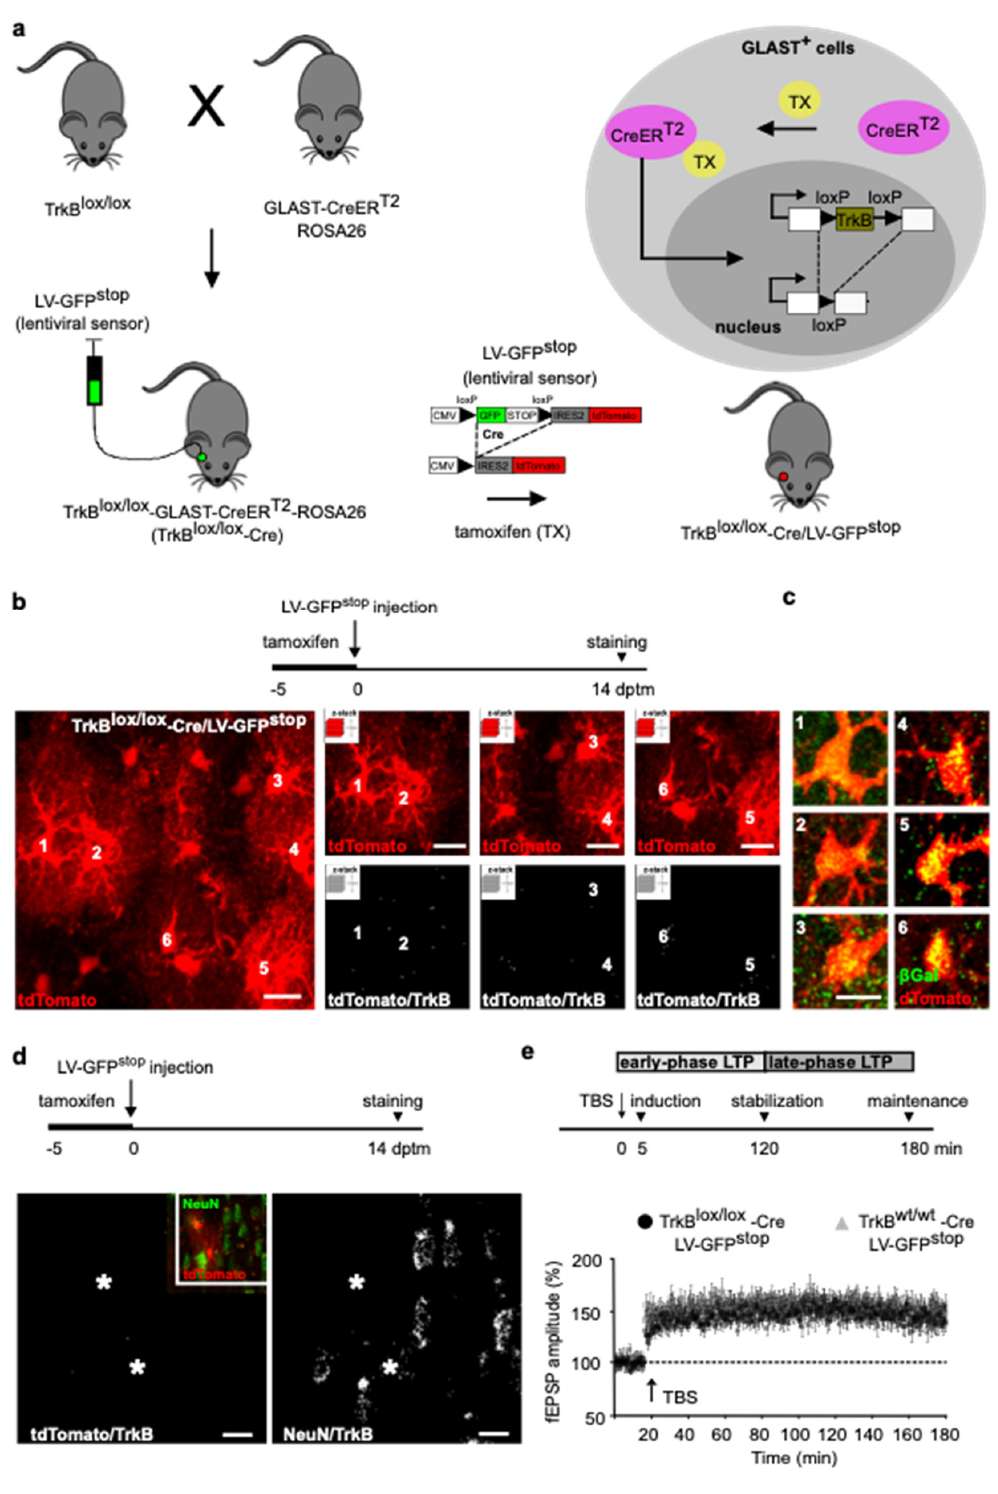
Figure 2. LTP evoked in cortical slices from TrkB lox/lox -Cre mice. ( a ) Schematic diagram depicting the experimental paradigm. TrkB lox/lox -Cre mice were generated by breeding TrkB lox/lox mice, expressing flanking exons 2 of the TrkB catalytic domain with loxP sites, with GLAST-CreER T2 mice, expressing the inducible version of the Cre recombinase (CreER T2 ) under the control of the GLAST promoter, crossed with ROSA26 mice. Tamoxifen treatment in TrkB lox/lox -Cre mice causes the CreER T2 fusion